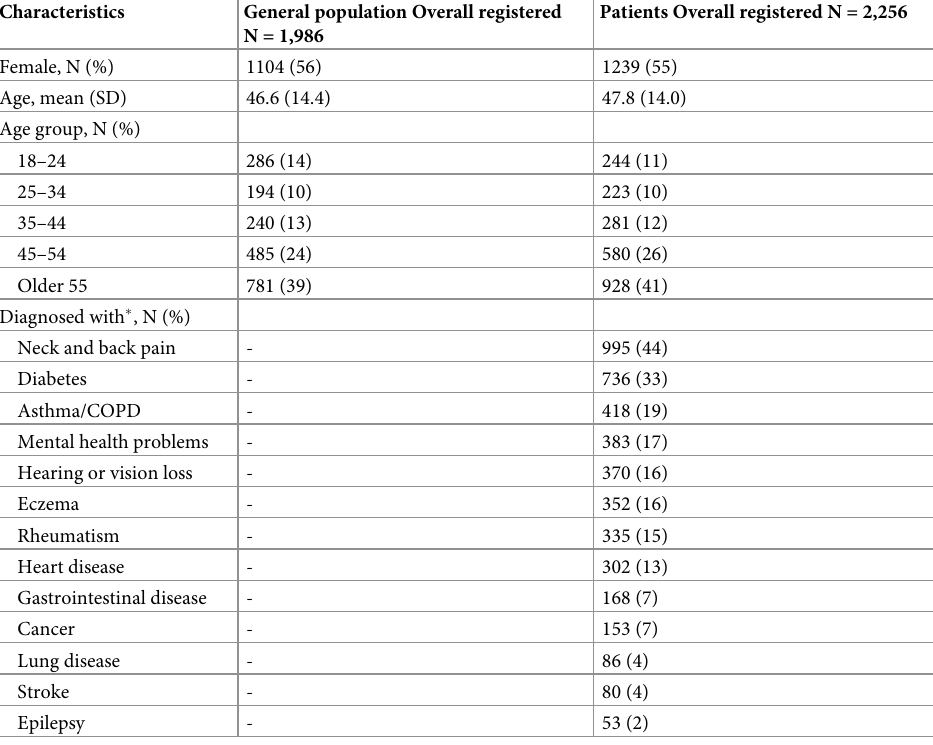
Table 2. Characteristics of the participants in two sub-samples used in the